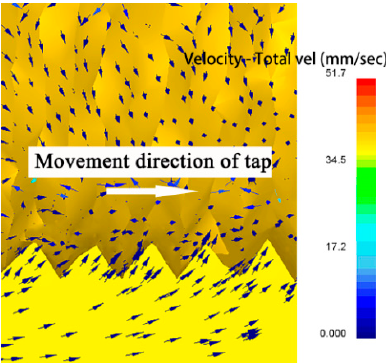
Figure 6. Velocity field distribution in the forming process.